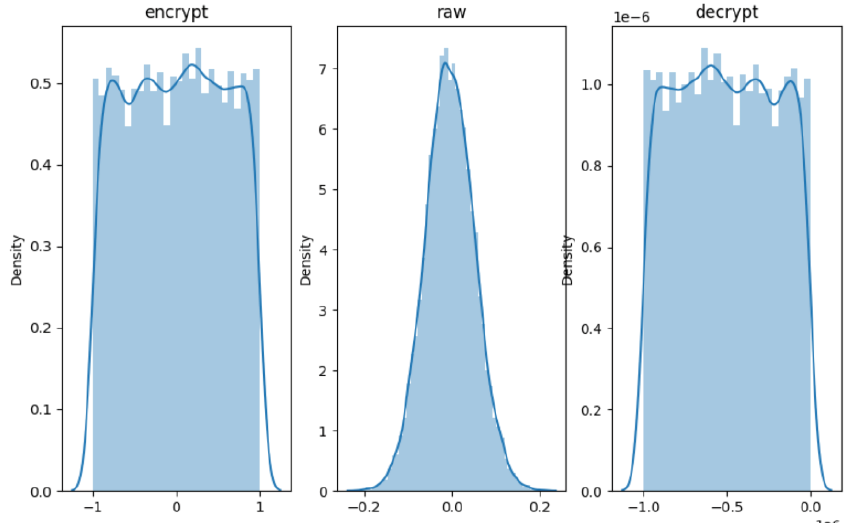
Figure 6. Data distribution of the attacker brute force at 0.1% data